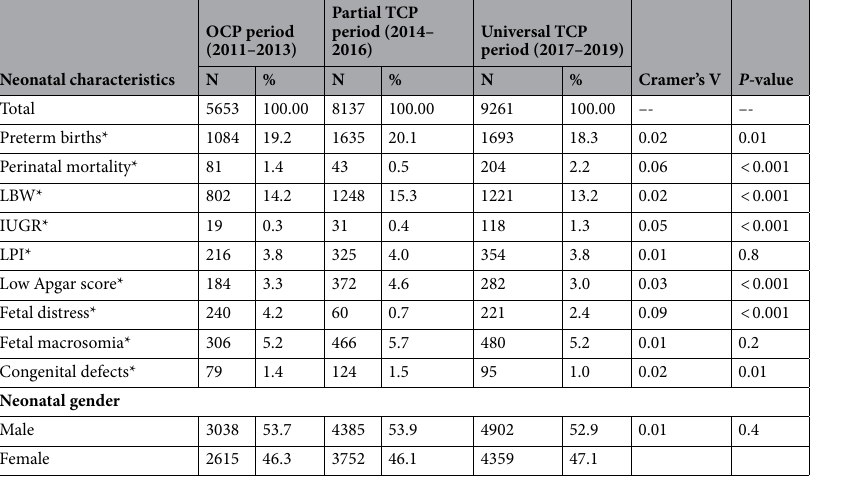
Table 3. Changes in neonatal characteristics from OCP (One-child policy) period to universal TCP (Two- child policy) period. * = Frequency and percentage of only ‘Yes’ value presented , LBW (Low birth weight), IUGR (Intrauterine growth restriction), LPI (Low ponderal index), congenital defects (microtia, anotia, polydactyly, heart defects, limb reduction defects, cleft lip, cleft palate, hydrocephaly, and NTDs), p-values were calculated using chi-square